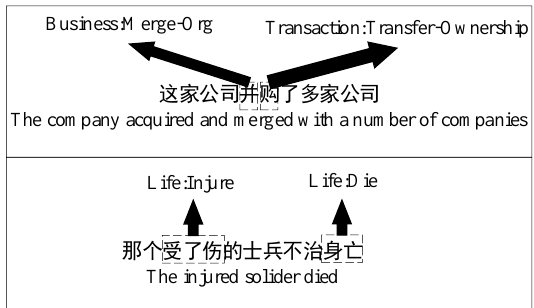
Figure 2. An example of trigger-word mismatch.